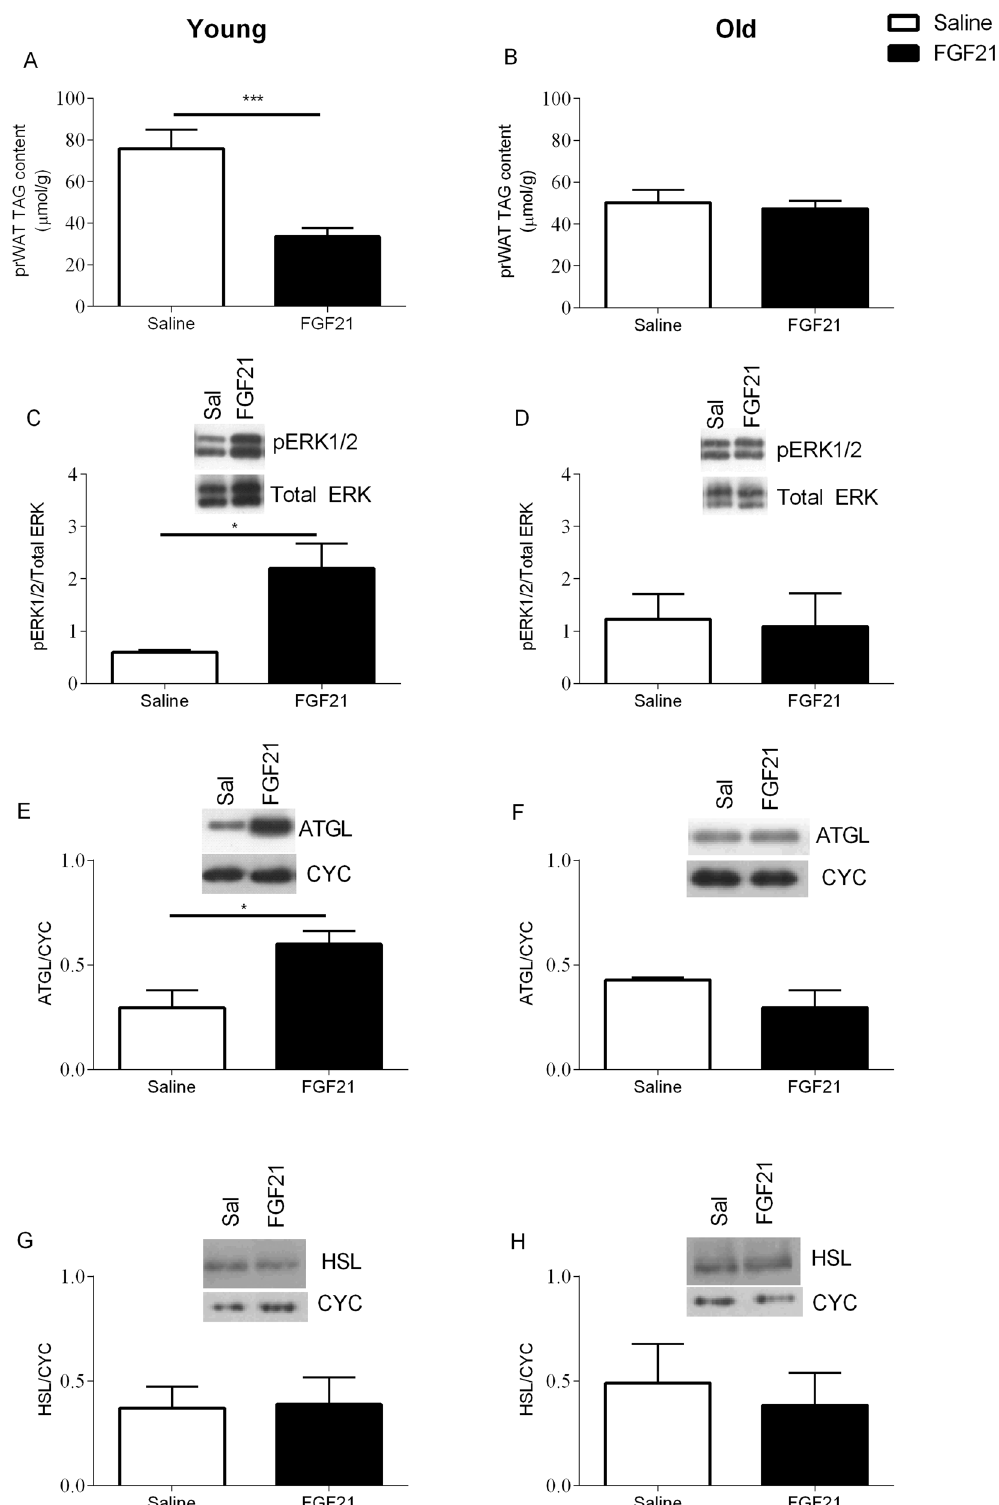
Figure 6. Treatment with FGF21 reduces prWAT TAG content and increases key phosphorylation events and AGTL in young Siberian hamsters. prWAT TAG content ( A and B ) of young and aged Siberian hamsters treated with FGF21. pERK1/2 and total ERK ( C and D ), ATGL ( E and F ) and HSL ( G and H ) content of prWAT. Values are group mean ± SEM, n = 5–6 per treatment: * p < 0.05 ** p <